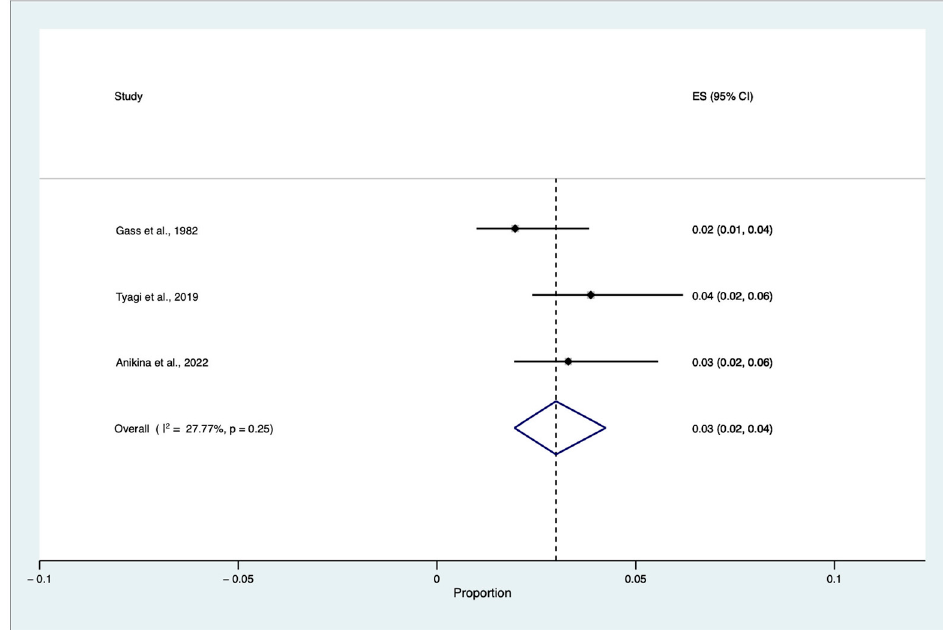
Figure 5. Proportional meta-analysis of cumulative sympathetic ophthalmia (SO) incidence triggered by single or multiple vitreoretinal (VR) surgery procedures in eyes without an antecedent history of trauma and previous ocular surgery, except for previous or concomitant uneventful lens extraction among patients who underwent VR surgery [9,14,20]. ES: e ff ect size, CI: con fi dence interval.